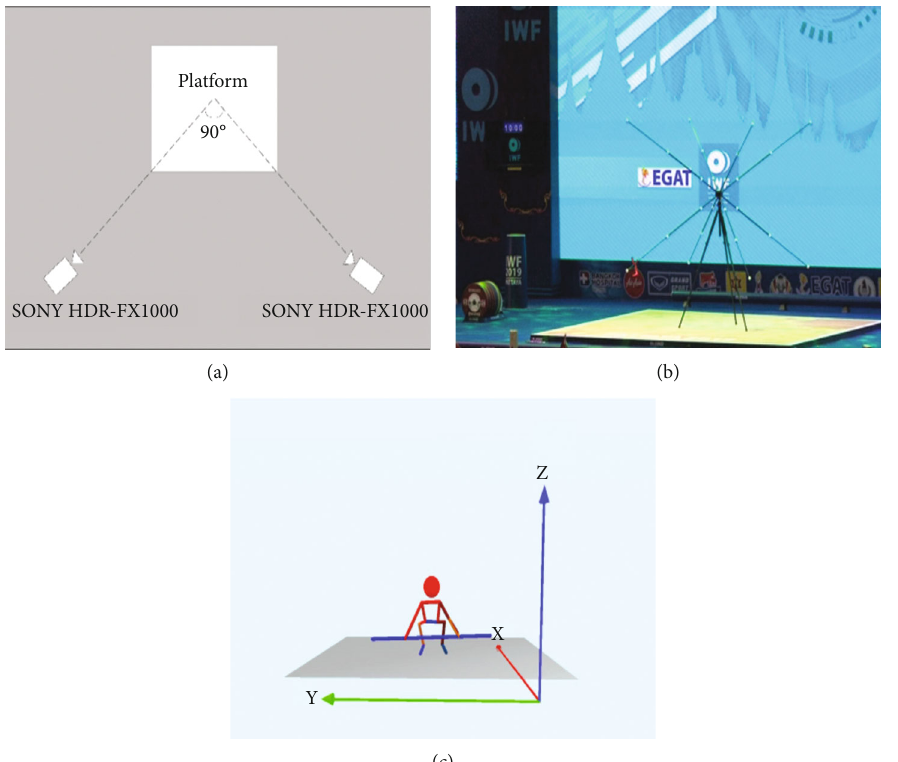
Figure 1: Experimental design and 3-D coordinate